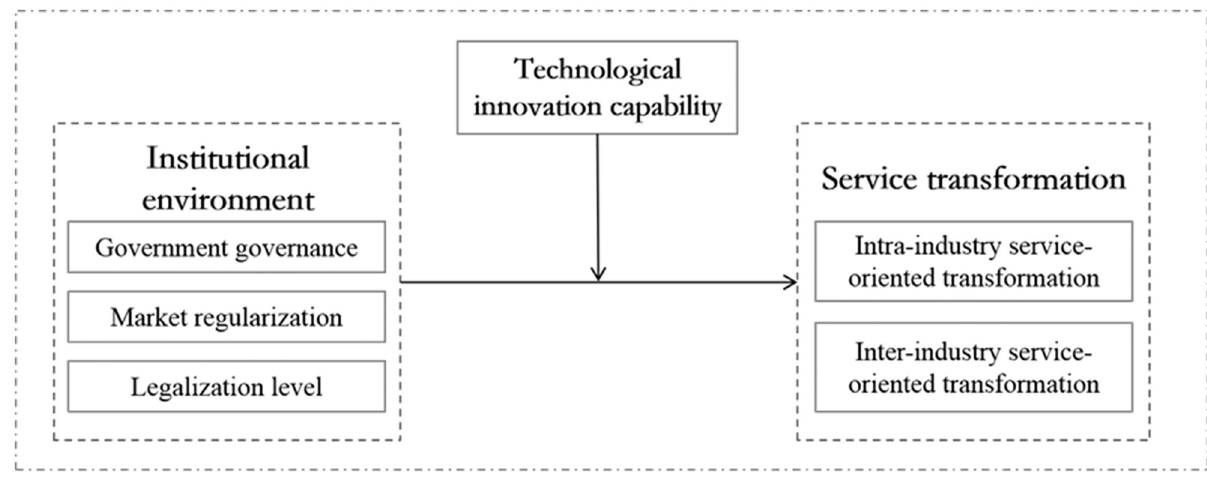
Fig 1. Framework